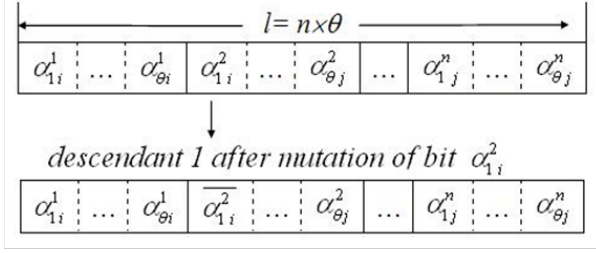
Figure 5. Operation of a mutation